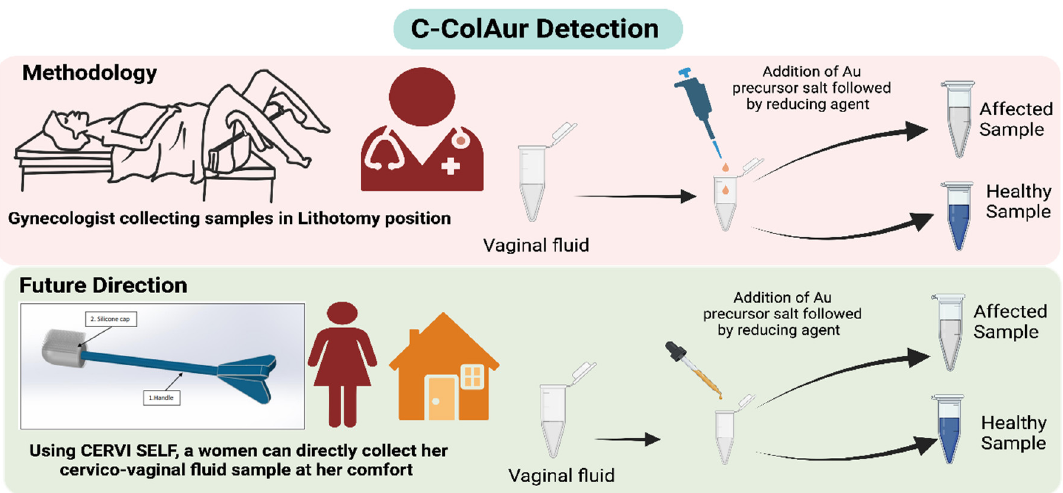
Figure 1. Schematic explaining the C -Col Au r detection and its future direction using C ervi S elf.